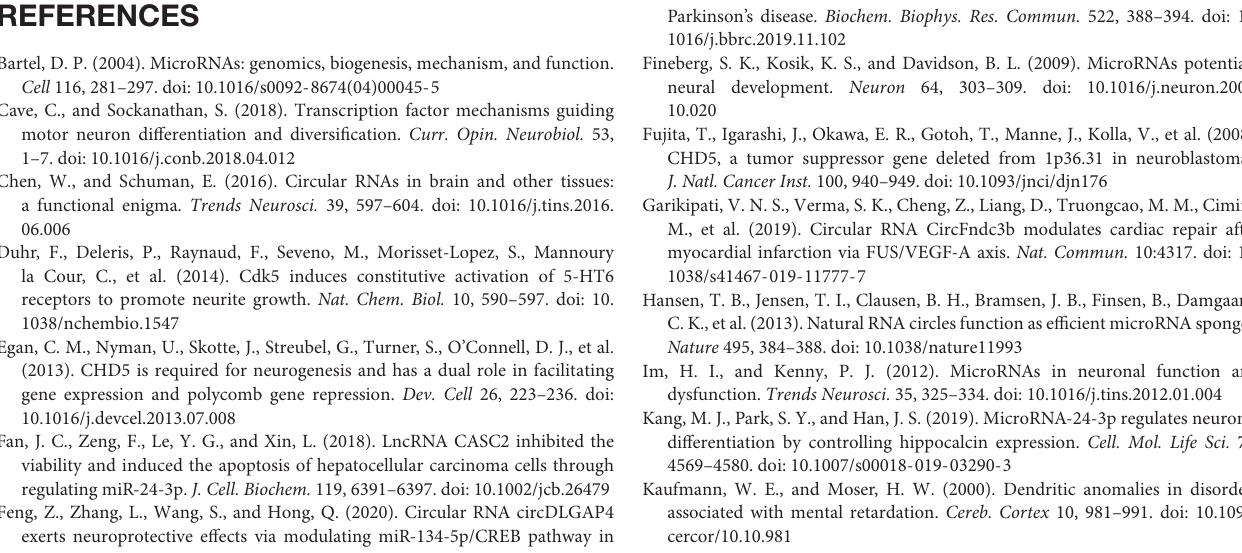
Supplementary Figure 1 | Expression levels of circRtn4, miR-24-3p and CHD5 during neuronal differentiation. The expression levels of circRtn4 (A,B) , miR-24-3p (C,D) and CHD5 (E,F) in N2a cells (A,C,E) and primary cortical neurons (B,D,F) at different differentiation time points were determined by qRT-PCR ( n = 3, ∗ p < 0.05, ∗∗ p < 0.01, and ∗∗∗ p < 0.001). Supplementary Figure 2 | The efficiency of miR-24-3p knockdown and overexpression. (A) The overexpression efficiency of miR-24-3p was determined by qRT-PCR. (B) After transfection of miR-24-3p inhibitor, the expression levels of miR-24-3p were detected by qRT-PCR. The results were shown as the mean ± SD ( ∗ p < 0.05, and ∗∗ p < 0.01, n = 3). Supplementary Figure 3 | CircRtn4 promotes neurite growth via miR-24-3p. (A) After transfected with miR-24-3p inhibitor or miR-24-3p mimic, N2a cells were fixed and immunostained with anti- β -tubulin III antibody and captured by a Zeiss LSM 710 confocal microscope with a 20 × objective (Red, β -tubulin III; Green, GFP). N2a cells were cotransfected with 100 nM miR-24-3p mimic (B–D) or inhibitor (E–G) and PEGFP vector (250 ng/ml). The branch numbers of neurite, the length of longest neurite and total length of neurites were quantified by Image-Pro Plus software. The results were shown as the mean ± SD ( ∗ p < 0.05, ∗∗ p < 0.01, and ∗∗∗ p < 0.001). (H) After transfected with circRtn4 or MUT-circRtn4 vector, N2a cells were fixed and immunostained with anti- β -tubulin III antibody and captured by a Zeiss LSM 710 confocal microscope with a 20 × objective (Red, β -tubulin III; Green, GFP). (I–K) N2a cells were transfected with